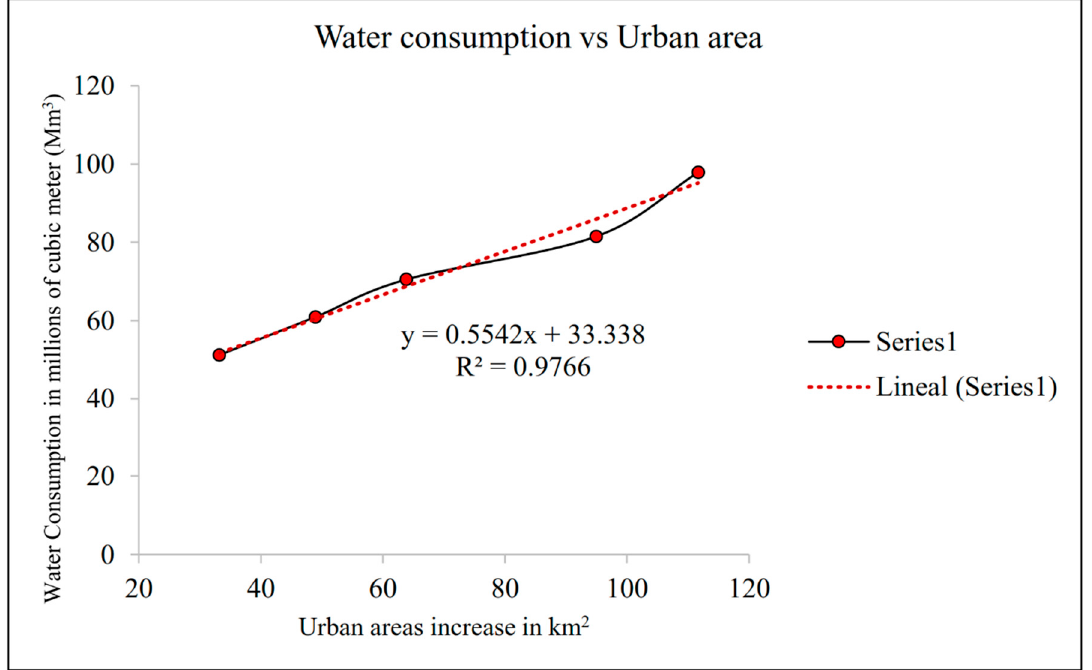
Figure 9. Relationship between urban growth and water consumption (Mm 3 ).